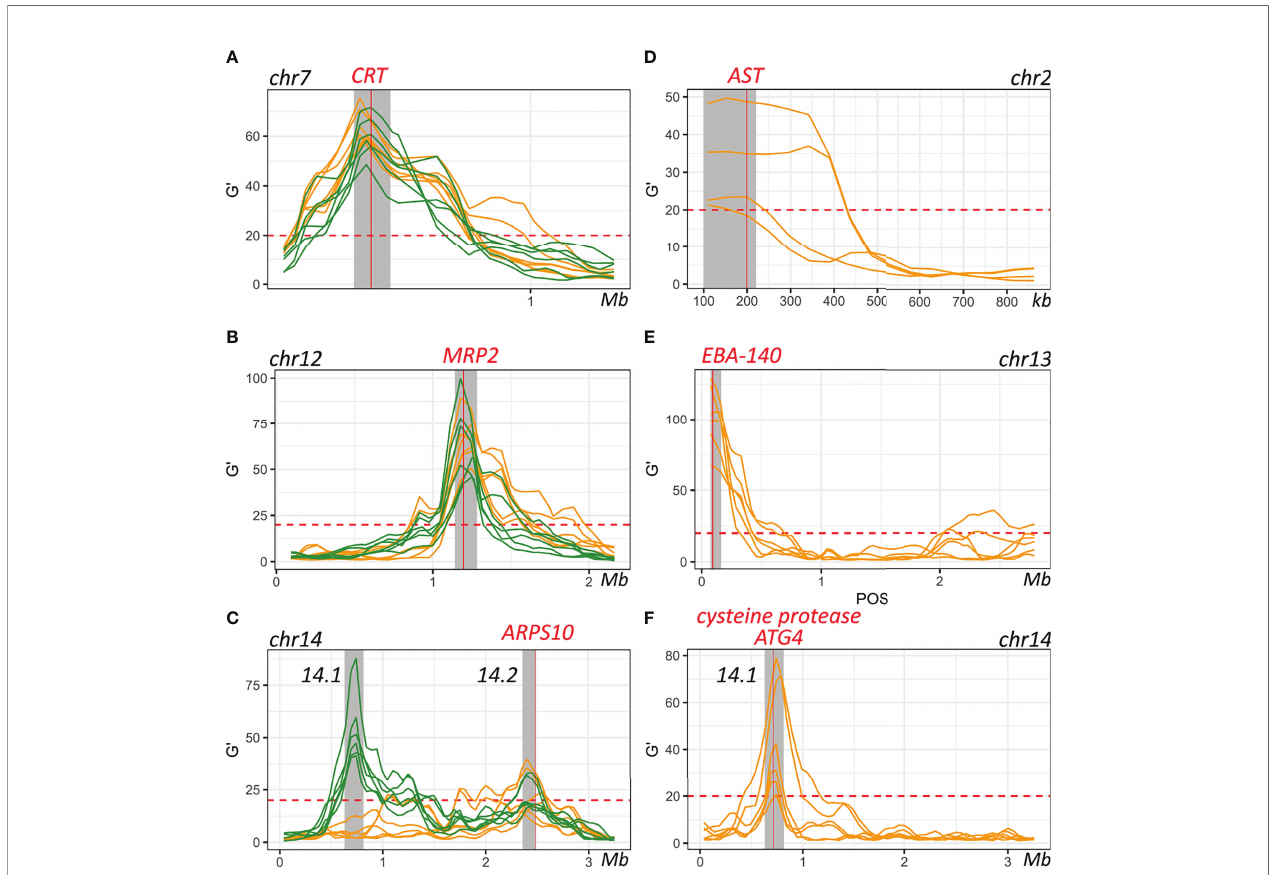
FIGURE 5 | Genes within de fi ned QTL regions. (A – C) . QTLs detected through comparing allele frequencies from the initial recombinant pools and pools after 30 days of serum (orange) or AlbuMAX (green) culture. (D – F) . QTLs detected by comparing serum and AlbuMAX after 30 days of culture. Each line is one comparison. Grey shadows indicate boundaries of the merged 95% con fi dential intervals (CIs) for each